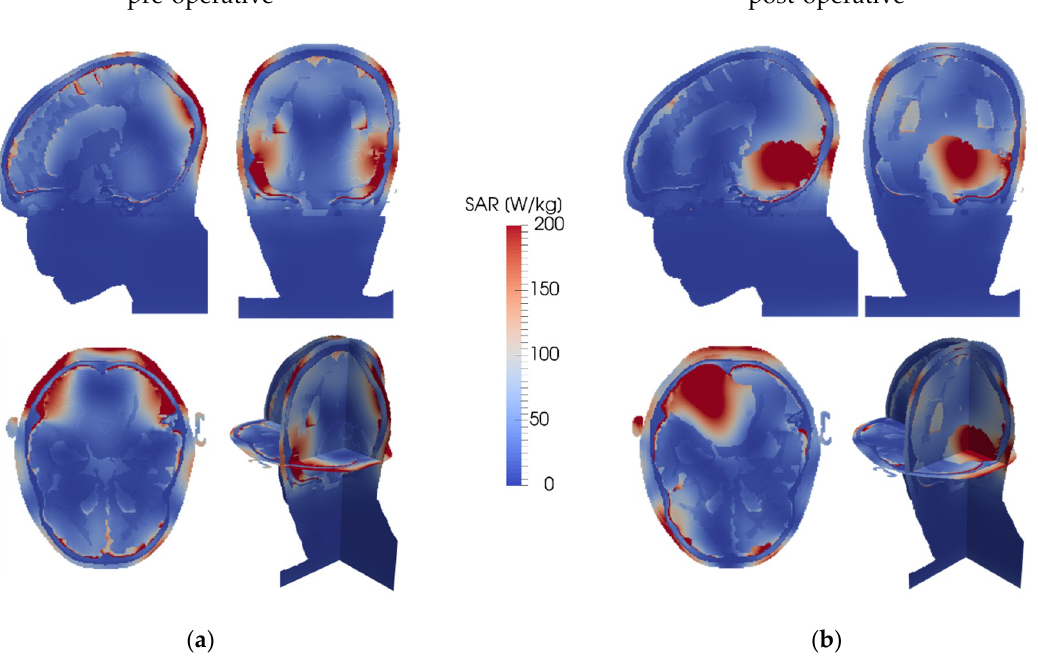
Figure 2. SAR distribution in the head model. The skull is clearly recognisable by its low energy uptake. Underneath the skull is typically a thin layer of CSF, which tends to have a high energy uptake. High SAR regions close to the head surface correspond with antennas with a high power output. The panels show planes through the tumour’s centre of gravity in the left-right (top-left), anterior-posterior (top-right), and cranial-caudal (bottom-left) directions, and a 3D view (bottom- right), for ( a ) the pre-operative case; ( b ) the post-operative case. The tumour is (faintly) outlined.